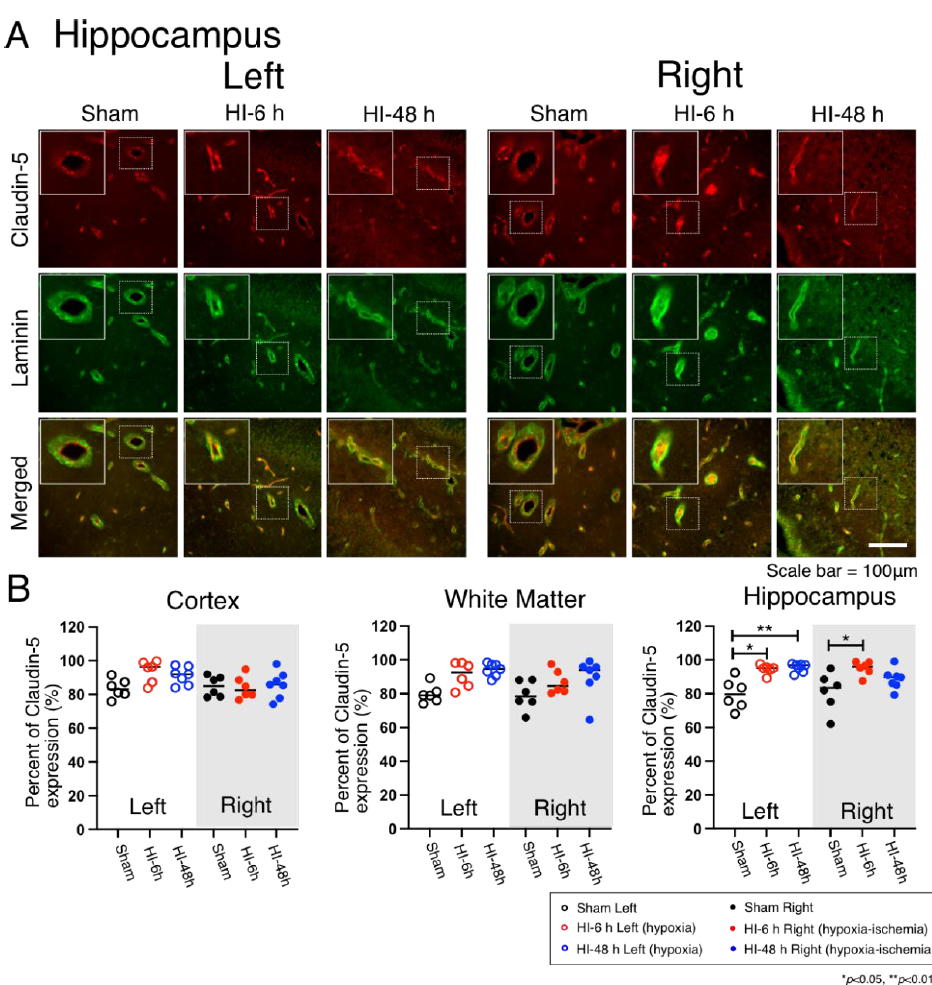
Figure 4. Immunohistochemical expression and quantification of vascular claudin-5 expression in the cerebral cortex, white matter, and hippocampus on the left hypoxic and right HI sides in the brain of the neonatal rats in the Sham, HI-6 h, and HI-48 h groups. ( A ) Representative images of claudin-5 (Claudin-5, Red), microvessels (Laminin, Green), and merged double immunostaining in the cerebral cortex of left hypoxic and right HI sides of rat brain in Sham, HI-6 h, and HI-48 h groups. Magnification, 40× . Each inset contains high magnification images. Scale bar = 100 μm. The immunohistochemical images in the cerebral cortex and hippocampus are shown in Supplementary Figure S3. ( B ) Quantification of vascular claudin-5 expression shown by percent of vascular claudin-5 expression in the cerebral cortex, white matter, and hippocampus of the hypoxic left and HI right sides of rat brain in Sham (left; black open circles, right; black closed circles), HI-6 h (left; red open circles, right; red closed circles), and HI-48 h (left; red open circles, right; red closed circles) groups. Values median and dot plots. * p < 0.05, ** p < 0.01.